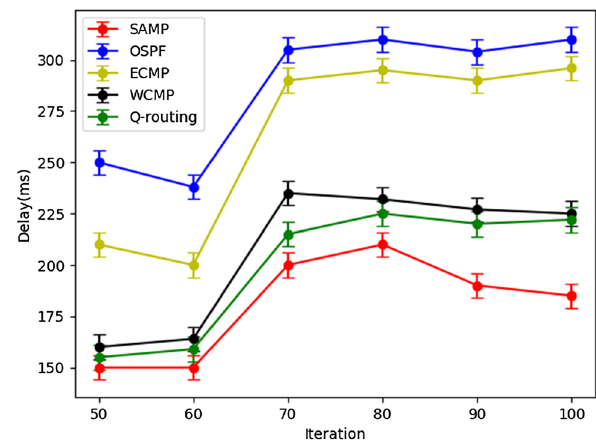
Fig. 11 Transmission delay under dynamic network